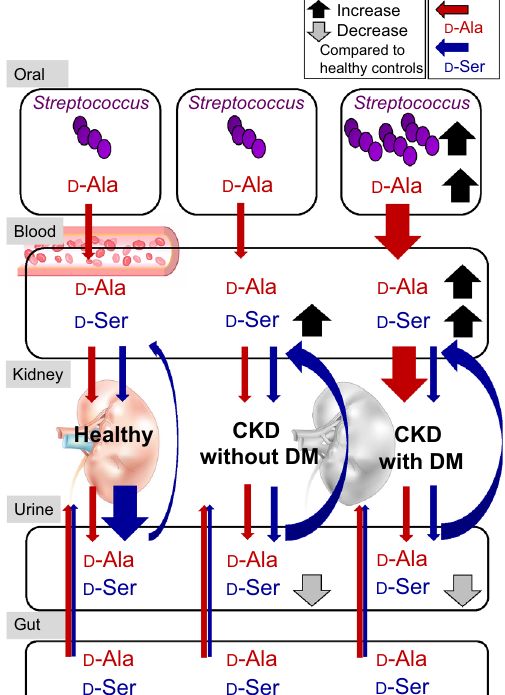
Figure 6. Proposed model of the relationship between oral Streptococcus -derived d-alanine (D-Ala) and kidney disease. d-Serine (D-Ser) and D-Ala were present in the blood and urine of healthy controls. Plasma D-Ser levels were higher, whereas urine D-Ser levels were lower in all patients with CKD than in healthy controls. However, the abundances of oral Streptococcus species and plasma D-Ala levels were higher in patients with CKD and DM than in those without DM. In addition, salivary D/L-Ala and plasma D-Ala levels were associated with positive estimated glomerular filtration rate slopes in patients with CKD and DM. CKD chronic kidney disease, DM diabetes